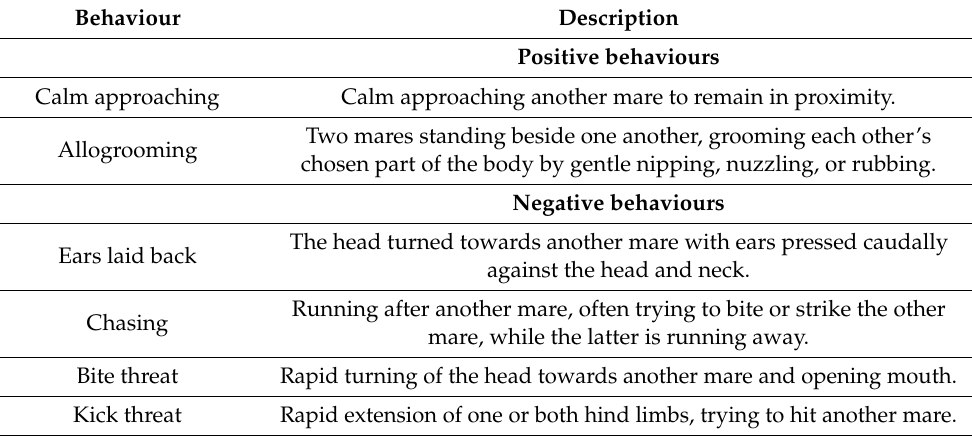
Table 3. Description of the behaviours towards conspecifics, recorded in the study ([19,20];